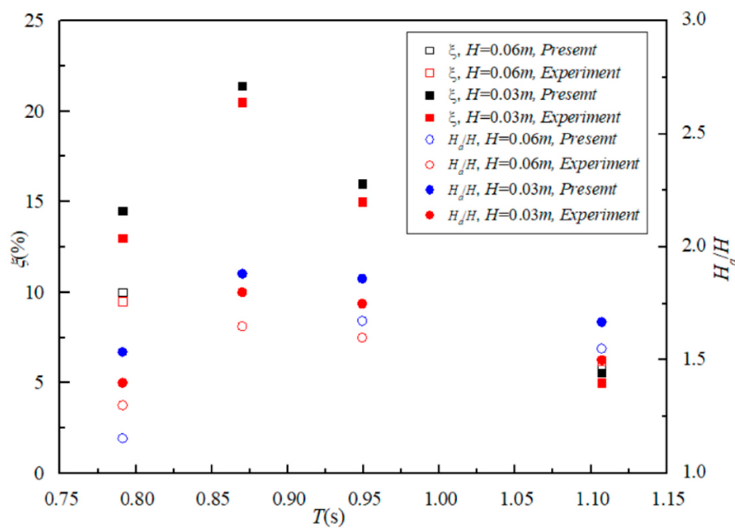
Figure 5. Comparison of the conversion efficiency ξ with different H a / H between the present model and experimental data.